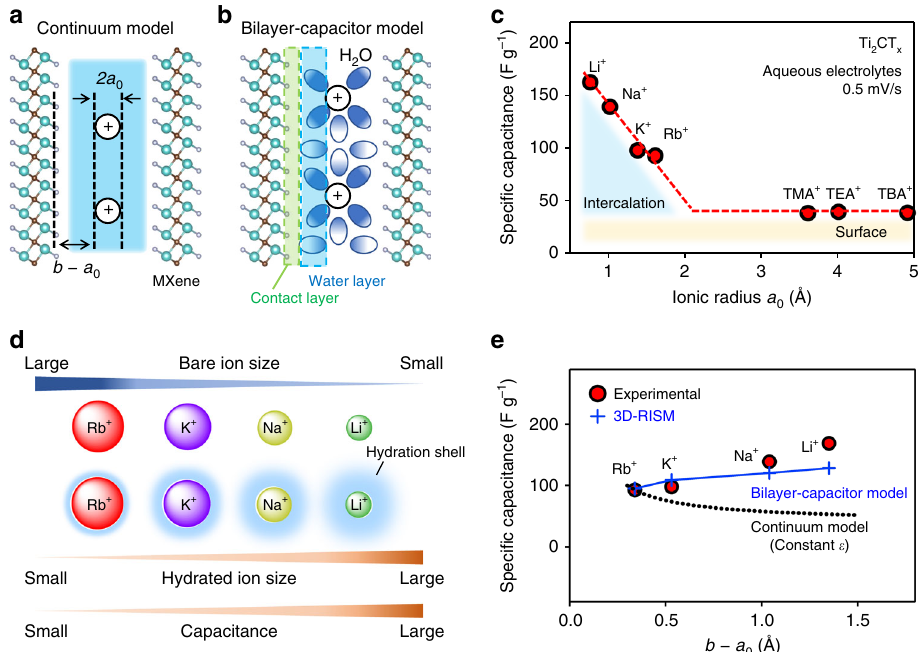
Fig. 1 Enlargement of the capacitance of a microslit capacitor. a Schematic illustration of a continuum model of a microslit capacitor consisting of MXene Ti 2 CT x nanosheets. Ti (dark cyan), C (brown), surface termination group T (gray) atoms are shown. b Schematic illustration of a bilayer-capacitor model. c Experimental speci fi c capacitance of MXene Ti 2 CT x with aqueous Li + , Na + , K + , Rb + , TMA + (tetramethylammonium), TEA + (tetraethylammonium), and TBA + (tetrabutylammonium) electrolytes. Each capacitance is calculated from the CV curve at the scan rate of 0.5 mV s − 1 . d Orders of bare-ion size, hydrated ion size, and observed capacitance. e Ion-MXene distance ( b − a 0 ) dependence of the experimental speci fi c capacitance. The black dotted line shows a calculated capacitance based on the continuum model ( C ¼ ε r ε 0 A b (cid:2) a with constant ε r ε 0 ), whereas the blue line shows a calculated capacitance based 0 on the bilayer-capacitor model with variable ε r ε 0 from the 3D-RISM